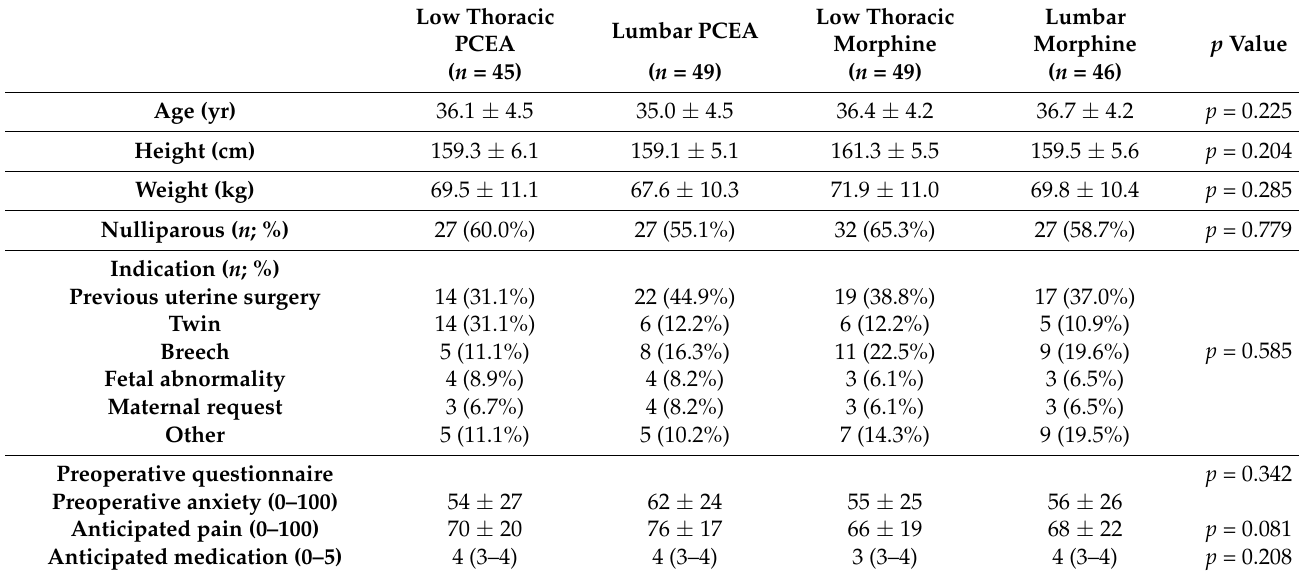
Table 1. Participant demographics and preoperative obstetric data.